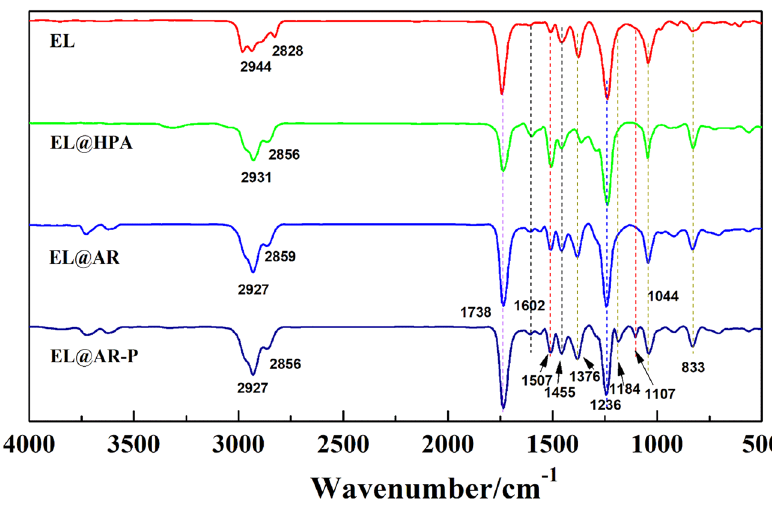
Figure 2: Infrared spectrum of EL, EL@HPA, EL@AR, EL@AR - P latex fi